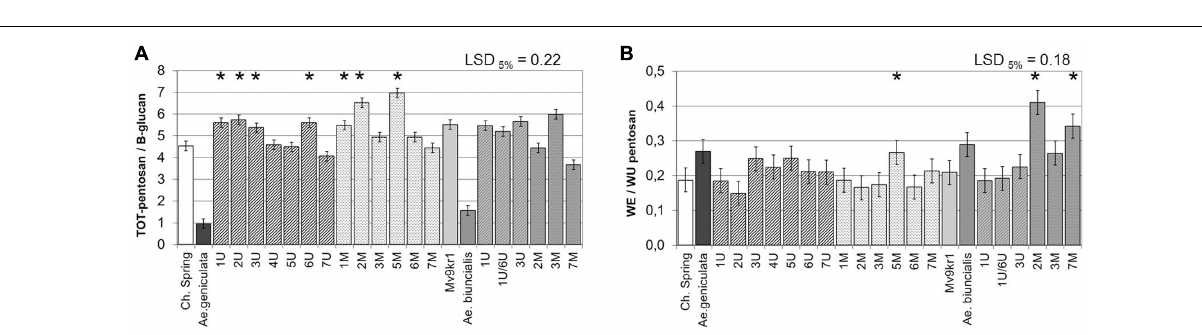
FIGURE 4 | Quantitative ratio of TOT-pentosan to β -glucan (A) and WE to WU-pentosan (B) in mature grains of two lines of bread wheat (cv. Chinese Spring and Mv9kr1 line), two Aegilops species ( Ae. geniculata and Ae. biuncialis ), and wheat– Aegilops chromosome addition lines. LSD, least significant difference; TOT, total; WE, water extractable; WU, water-unextractable. ∗ Significantly higher than the wheat ( T. aestivum )